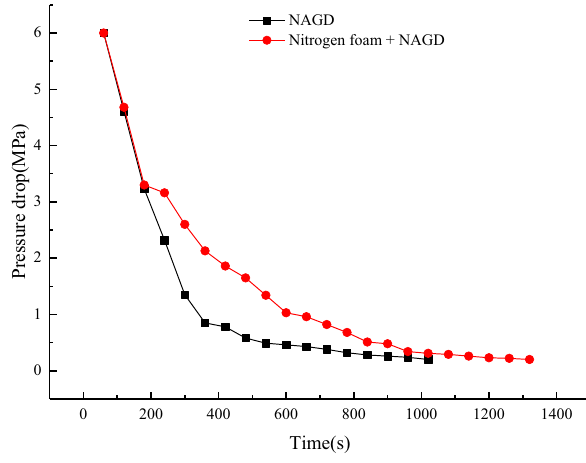
Fig. 7 Pressure drop curve (Experiment condition: temperature 80 °C, gas cap volume 0.5 PV, pressure of gas cap 1 MPa, formation dip angle 15°, back pressure 0.5 MPa)